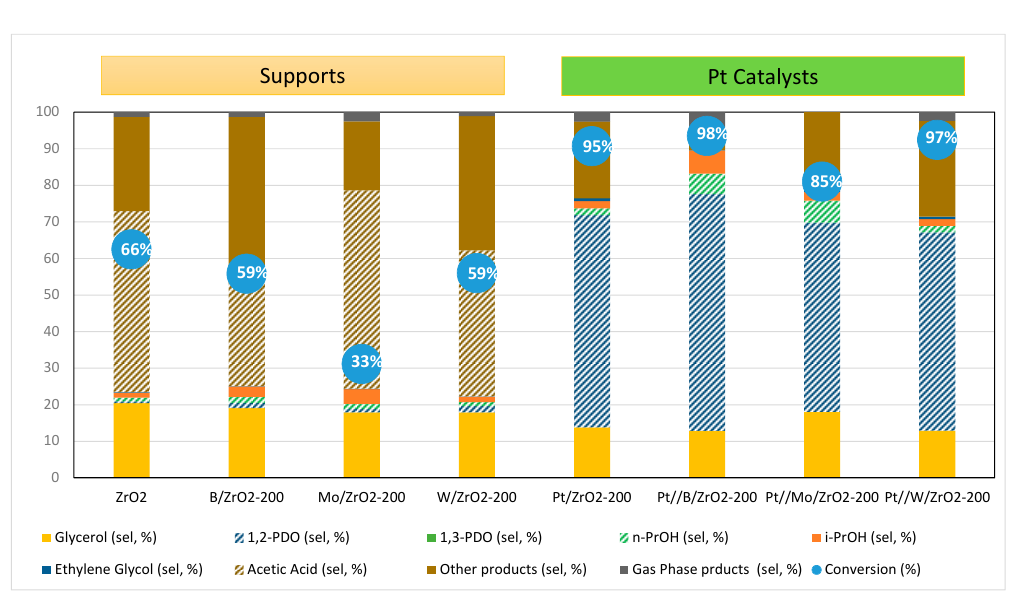
Figure 8. Acetol conversion and products selectivity obtained for bare supports and reduced Pt catalysts in the liquid-phase acetol transformation under reductive atmosphere. Reaction conditions: catalyst/support, 100 mg; H 2 initial pressure, 6 bars; reaction temperature, 180 ◦ C; reaction time, 4 h; aqueous acetol 0.5 M (10